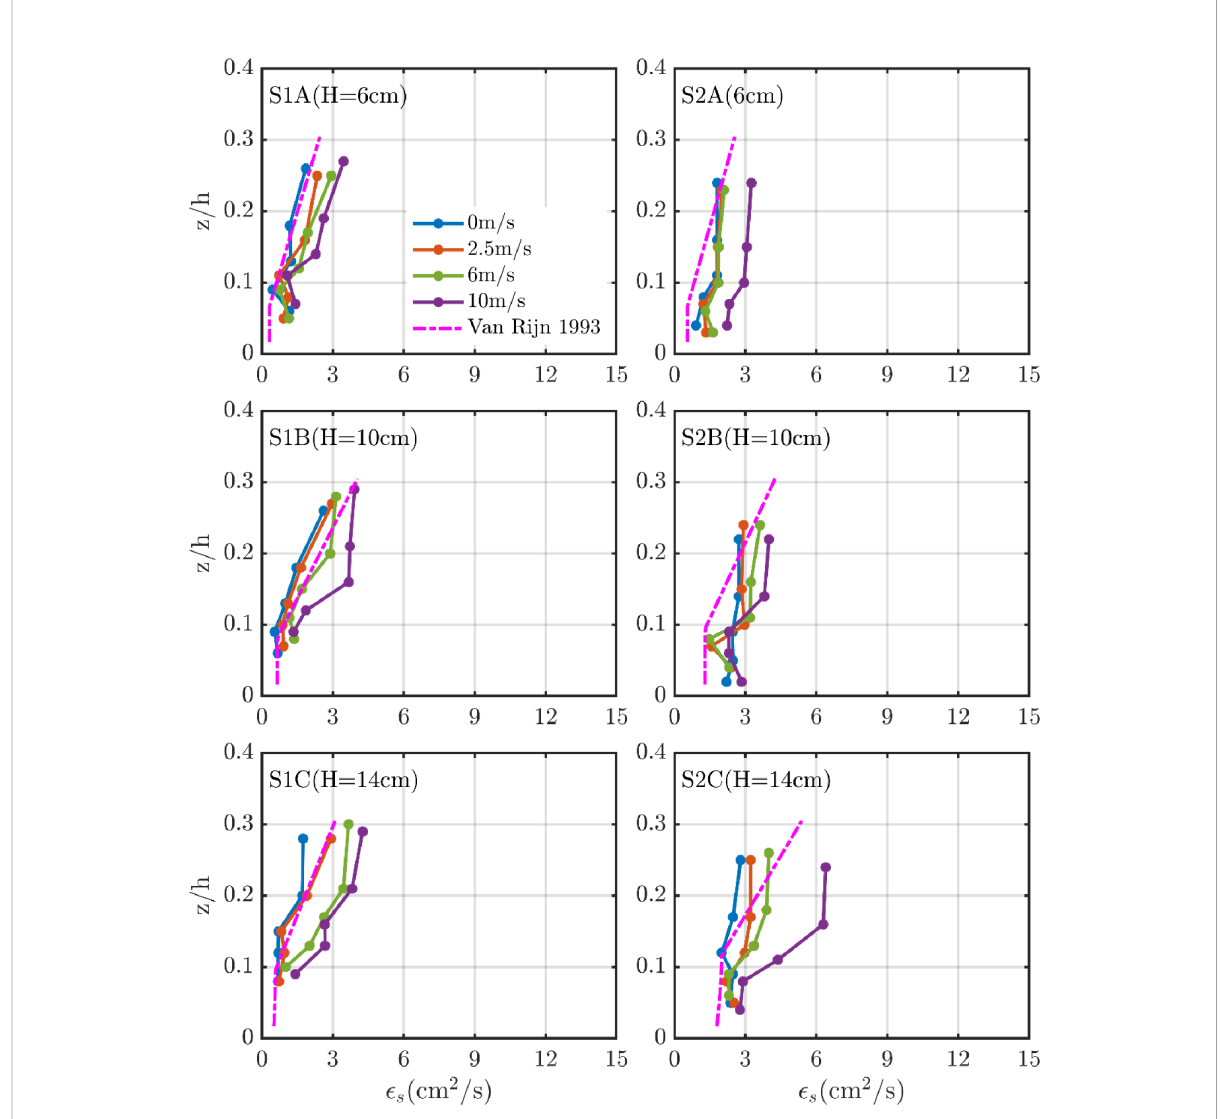
FIGURE 10 The sediment mixing coef fi cient, ϵ s of each case, and the pink dotted dash lines are the theoretical modeled results of Van Rijn et al.